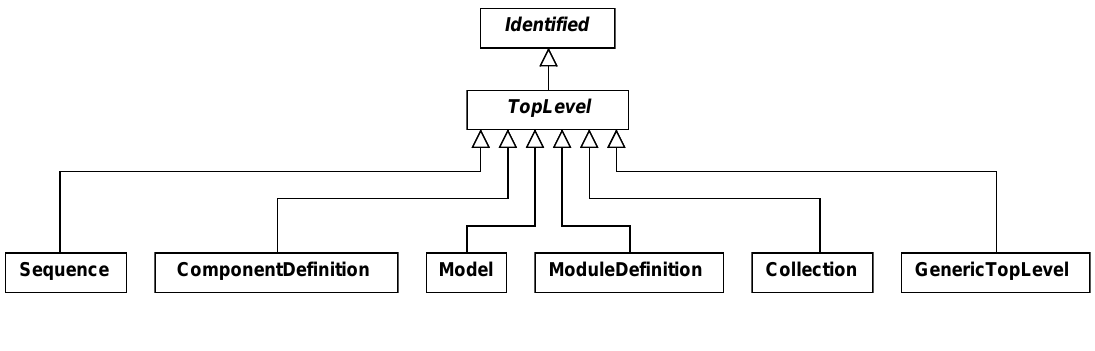
Figure 5: Classes that inherit from the TopLevel abstract